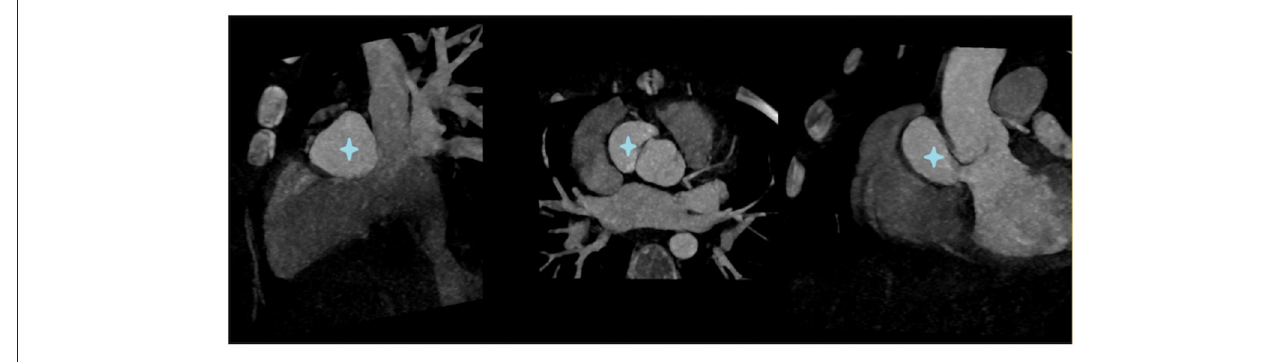
FIGURE 3 | CT scan showing a para-aortic pseudoaneurysm ( ).